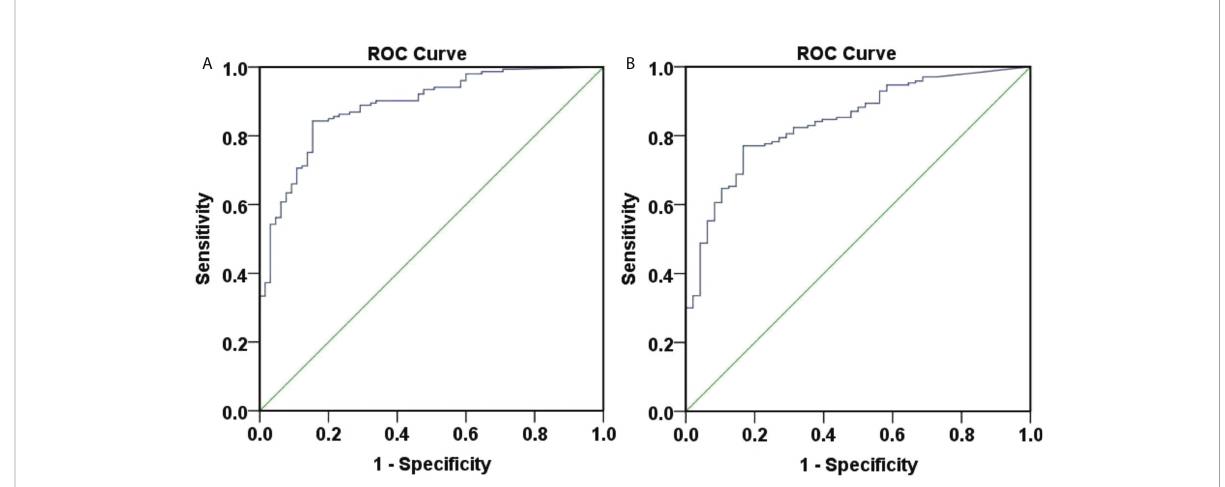
FIGURE 6 ROC curve of 48-weeks HBsAg clearance and seroconversion predicted by 12-week HBsAg. (A) ROC curve of 48-weeks HBsAg clearance predicted by 12-week HBsAg. The area under the curve was 0.888, 95% CI (0.843, 0.934), with good accuracy. The optimal cut-off value of week 12 HBsAg was 34.99 IU/ml, the Youden index was 0.689, the sensitivity was 0.843, and the speci fi city was 0.846. When the sensitivity was 95%, the HBsAg value was 4.715 IU/ml, and when the speci fi city was 95%, the HBsAg value was 198.6 IU/ml. (B) ROC curve of 48-weeks HBsAg seroconversion predicted by 12-week HBsAg. The area under the curve was 0.842, 95% CI (0.785,0.900), with good accuracy. The optimal cut- off value of week 12 HBsAg was 34.99 IU/ml, the Youden index was 0.603, the sensitivity was 0.771, and the speci fi city was 0.833. When the sensitivity was 95%, the HBsAg value was 1.425 IU/ml, and when the speci fi city was 95%, the HBsAg value was 161.95 IU/ml.